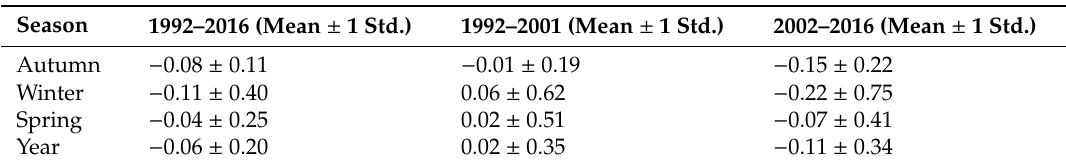
Table 5. Mean variation rate of the average SD (cm yr − 1 ) over the Northern Hemisphere for the three study periods (1992–2016, 1992–2001, and 2002–2016) and snow cover seasons (autumn, winter, and spring). Std. is standard deviation.